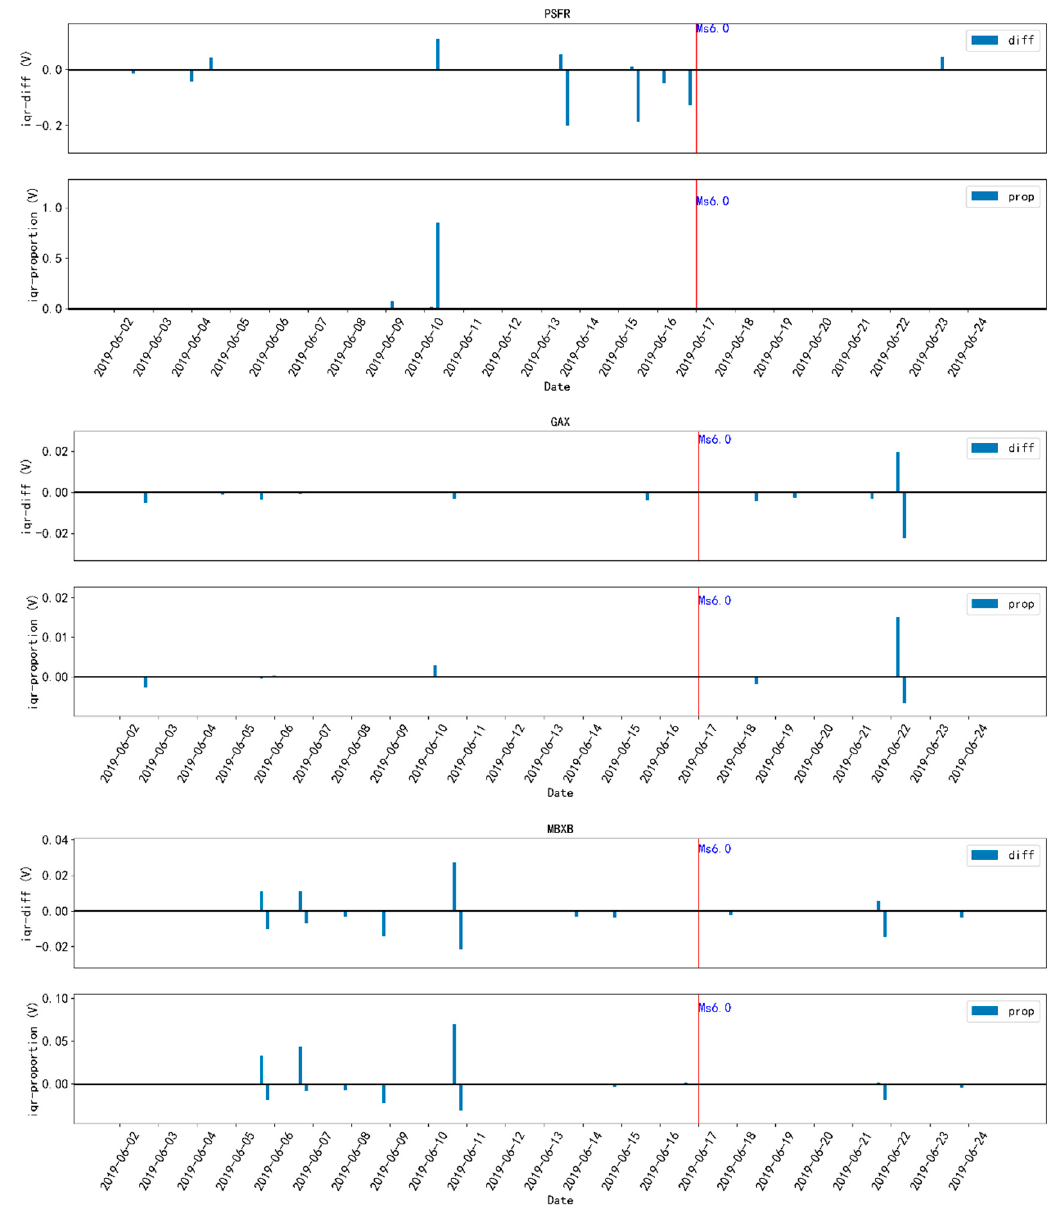
Figure 10. The abnormal values in PSFR, GAX and MBXB stations before the Yibin